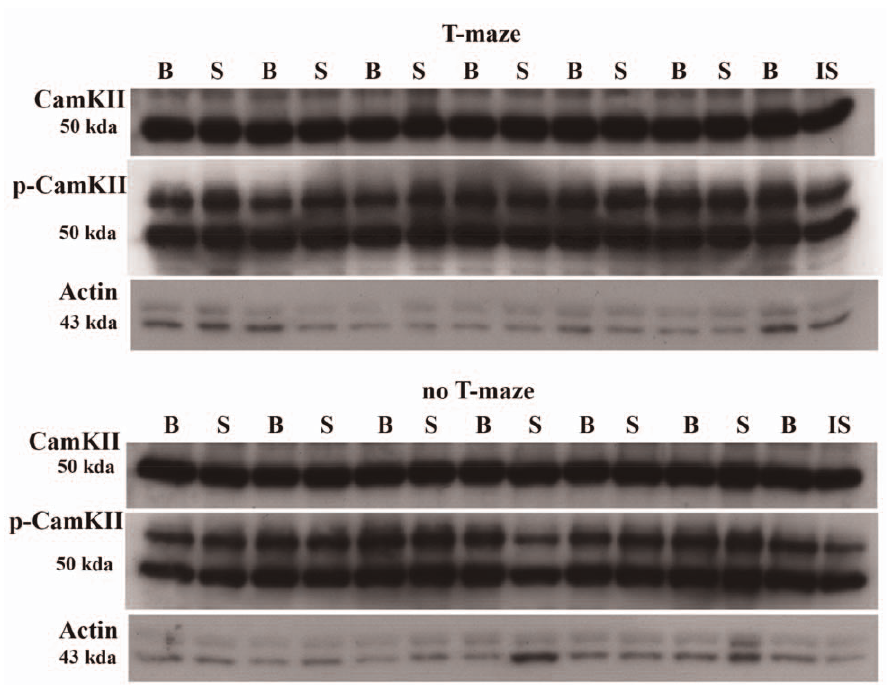
Figure 3. Example of western blots for CamKII a and pCaMKII a in CA2/3 for the BVD (‘B’) and sham (‘S’) animals that received T maze training or no T maze training at 6 months post-op. ‘IS’ is the internal standard and b -actin (‘Actin’) is also shown. a calibrated imaging densitometer (Bio-Rad) and a PowerPC Mac